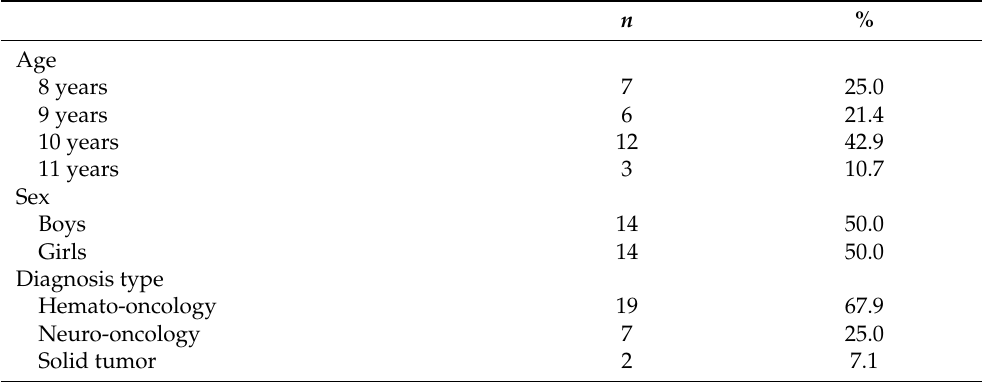
Table 2. Participant characteristics ( n =